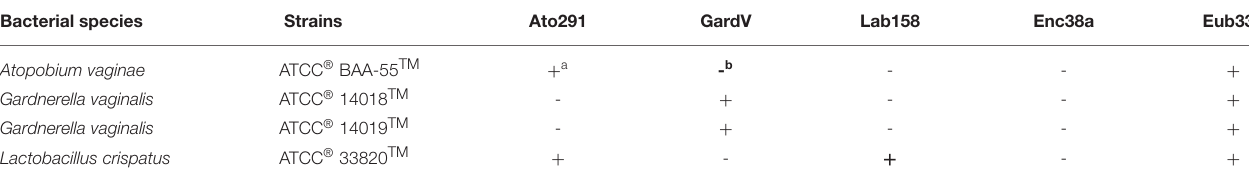
TABLE 3 | Probe specificity test results of the oligonucleotide probes using reference